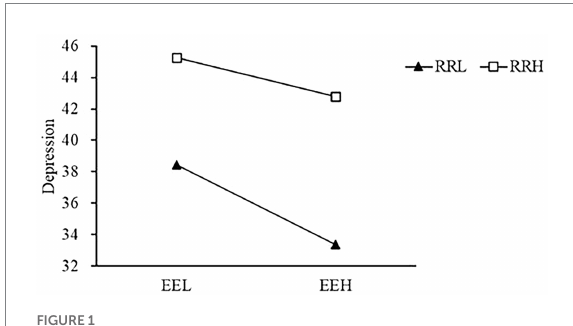
FIGURE 3 The moderating effect of attentional shift on the relationship between cognitive empathy and depression. ASL, low attentional shift; ASH, high attentional shift; CEL, low cognitive empathy; and CEH, high cognitive